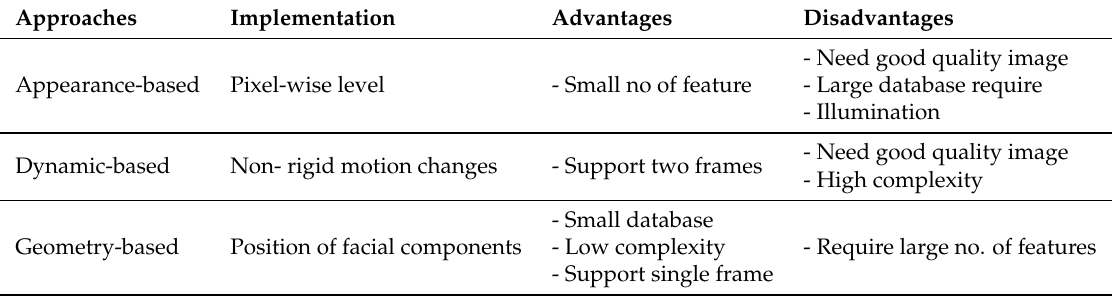
Table 1. Comparison between various feature extraction